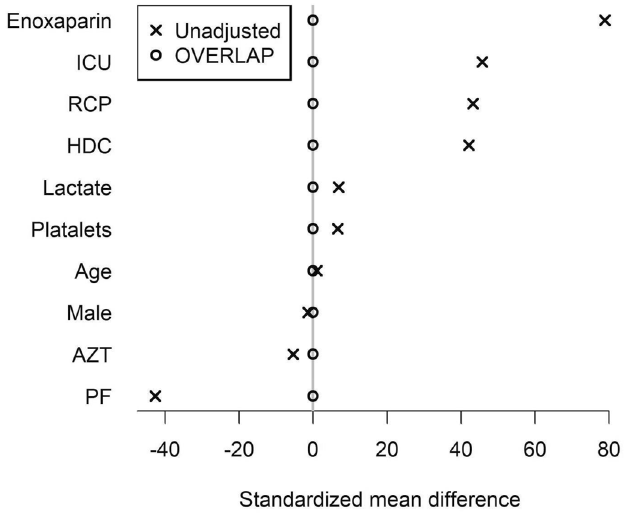
Figure 1. Covariance balance plot before and after overlap weights propensity matching for patients treated with corticosteroids and patients not treated with corticosteroid, expressed with standardized mean difference for comparability. ICU, Intensive Care Unit admission; RCP, Reactive C Protein; HDC, treatment with Hydroxychloroquine; AZT, treatment with Azithromycin; PF, PaO 2 /FiO 2 ratio.